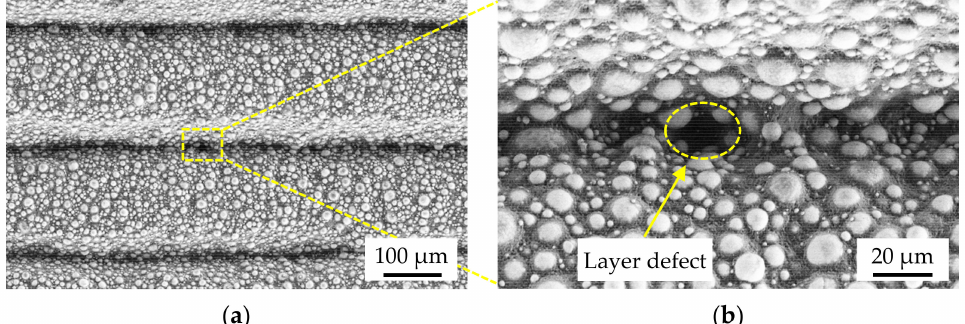
Figure 13. SEM images of a test specimen printed at v = 8 mm/s, T = 95 ◦ C and F e = 1300 N with an exemplary layer defect in the z-x plane at different magnification levels: ( a ) 100 × ; ( b ) 500 ×